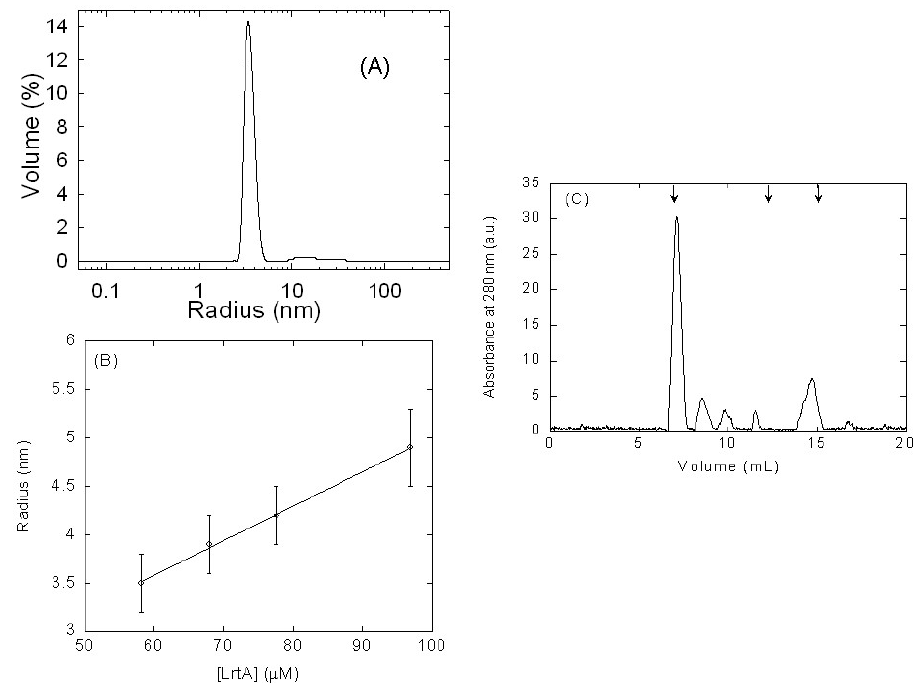
Figure 1. Hydrodynamic measurements of LrtA by dynamic light scattering (DLS) and size exclusion chromatography (SEC): ( A ) DLS measurements of the hydrodynamic radius RS of LrtA as a function of the percentage of the volume peak at 68 µ M concentration (in protomer units). ( B ) Variation of the calculated R S with LrtA concentration (in protomer units). Error bars are standard deviations from the fitting to a spherical shape. ( C ) SEC chromatogram of LrtA at 97 µ M (in protomer units) at pH 8.0 (50 mM Tris) in 0.7 M NaCl; the arrows at the top indicate (from left to right) the elution volumes of blue dextran (7.1 ± 0.1 mL), albumin (12.1 ± 0.1 mL; 63.7 kDa), and bovine RNase A (15.1 ± 0.1 mL; 15.7 kDa) (the errors are standard deviations of three independent measurements). Chromatogram was baseline-corrected by UNICORN 5.01 software (GE Healthcare), and therefore, the origin of the sharpening observed in the peaks. Experiments were carried out at 25 ◦